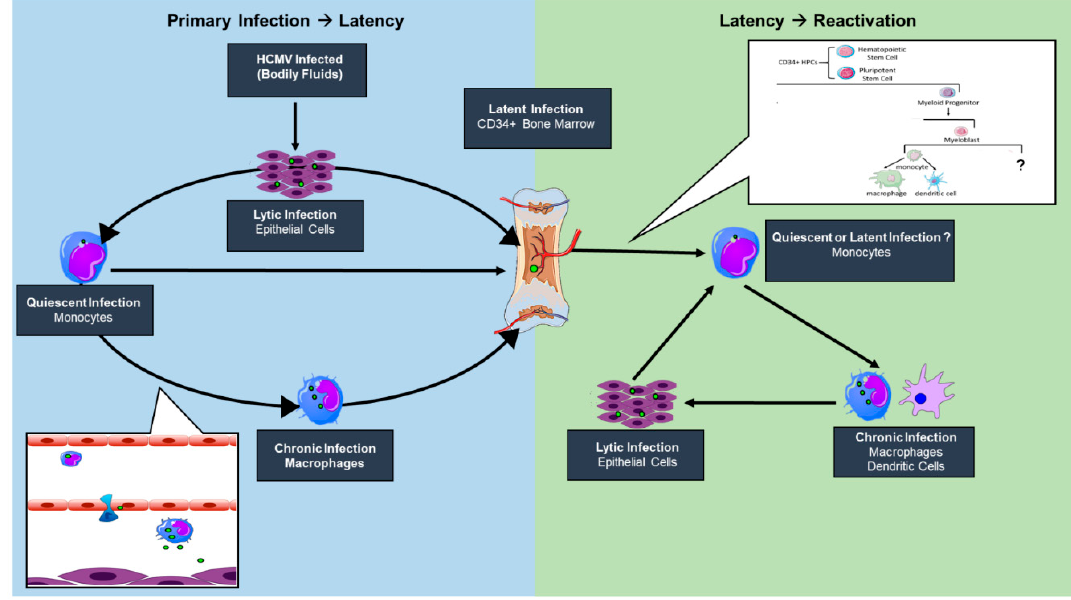
Figure 1. A model of human cytomegalovirus (HCMV) infection reservoirs. An initial round of lytic replication occurs in mucosal epithelial cells following virus exposure. Circulating monocytes are infected through contact with an infected epithelial cell and induce monocyte-to-macrophage differentiation and extravasation to peripheral tissues, including the bone marrow where a latent infection is established. Upon a reactivation signal, HCMV can induce the differentiation and mobilization of latently infected CD34+ bone marrow cells. While not entirely defined, HCMV may stimulate CD34+ human progenitor cell (HPC) differentiation down a monocytic lineage with an eventual terminal differentiation state of an infected macrophage or dendritic cell. These terminally differentiated cells allow for the reseeding of epithelial cell layers within peripheral organ sites.